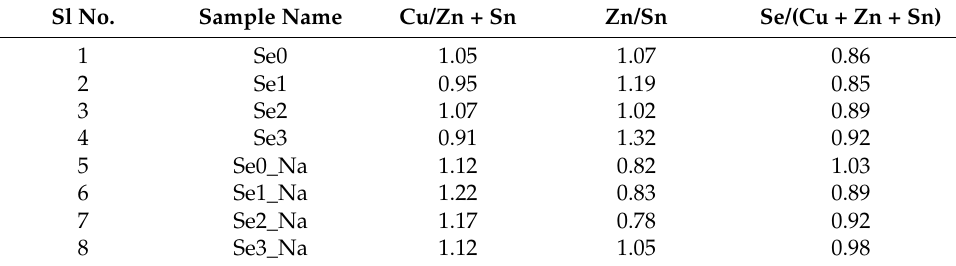
Table 1. Elemental composition of CZTSe without and with sodium layer.